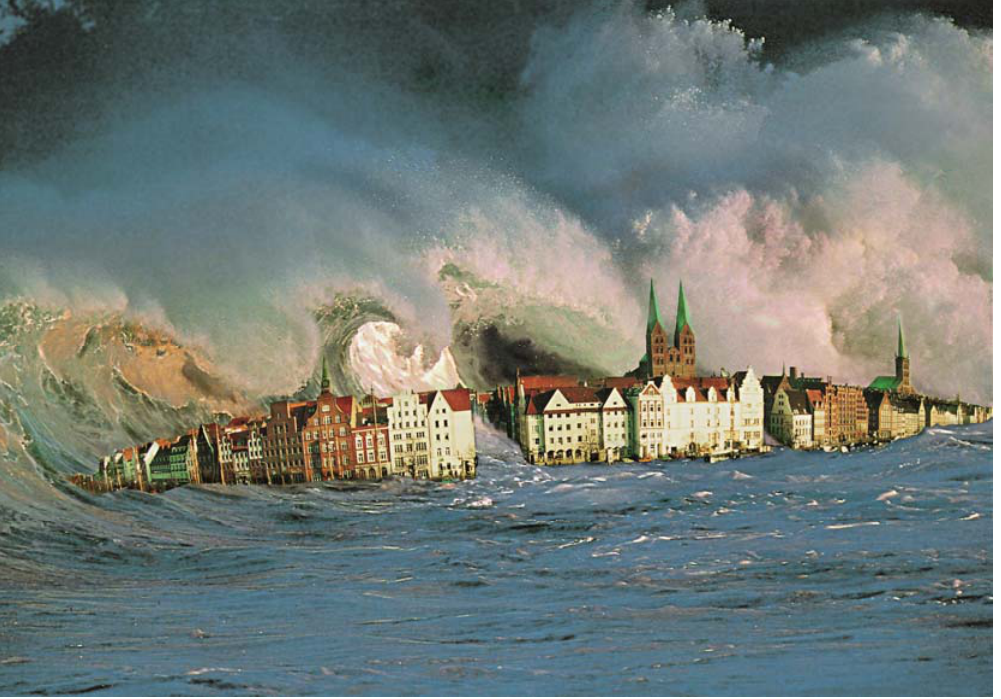
Source: Frank Mentz, Lübecker Nachrichten